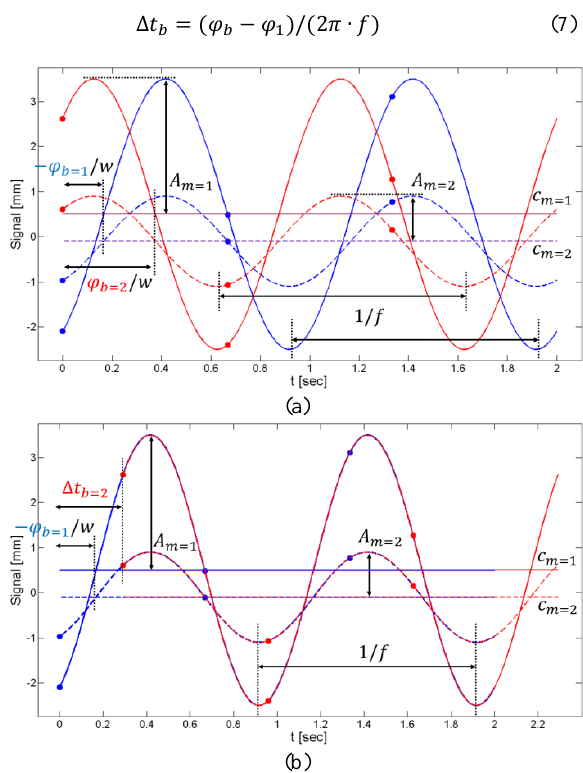
Figure 5. Example of two bursts with a common frequency (1 Hz), but different phase, where the same two features in the different bursts have the same amplitude and mean signal value (a); the two bursts superimposed after applying the phase shift as to show the de-facto increase in the sampling frequency from 1.5 Hz to 3 Hz (b) Figure 6. The unknowns for a sinusoidal fitting adjustment combining multiple bursts